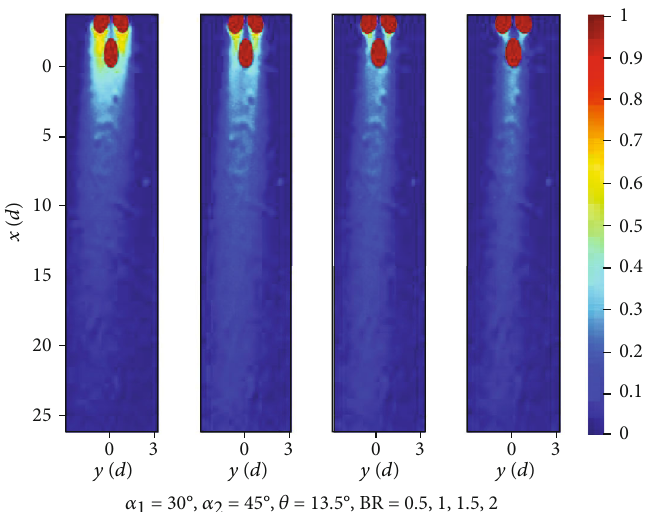
Figure 14: Film cooling e ff ectiveness distributions downstream of the branched holes, α